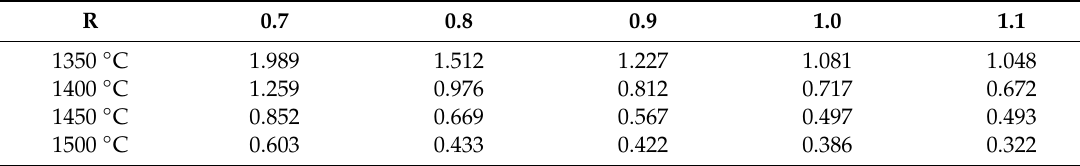
Table 3. The viscosity of BFS with di ff erent basicities / (Pa ·